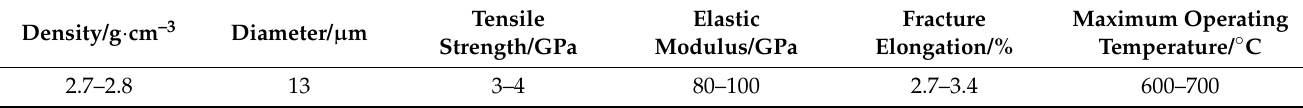
Table 2. Physical and mechanical characteristics of short-cut basalt fiber.